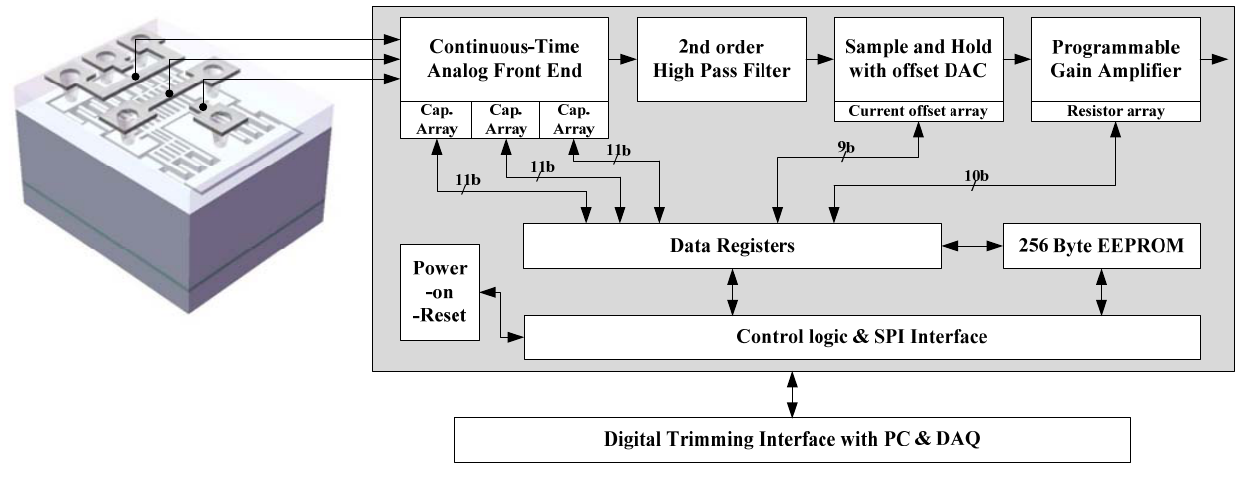
Figure 1. Top level block diagram of the two-chip implemented